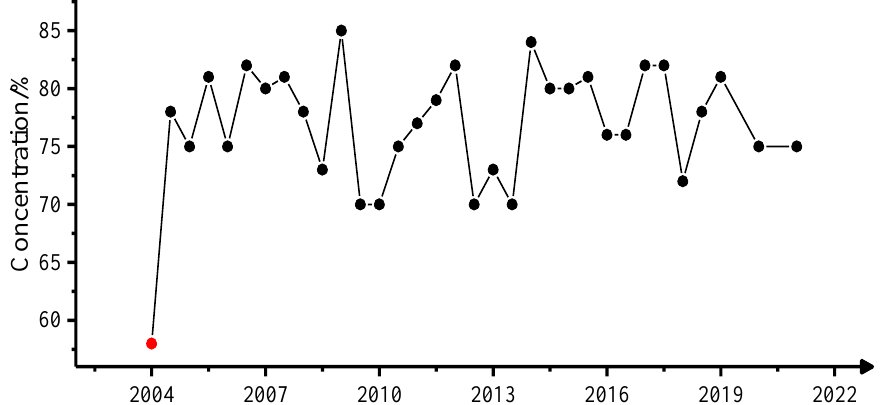
Figure 12. Variation trend in the concentration of the cemented filling slurry over the years. The red dots indicate that the concentration of the cemented filling slurry has not been reached since the previous time, while the black dots indicate that the concentration of cemented filling slurry has been reached later in time.